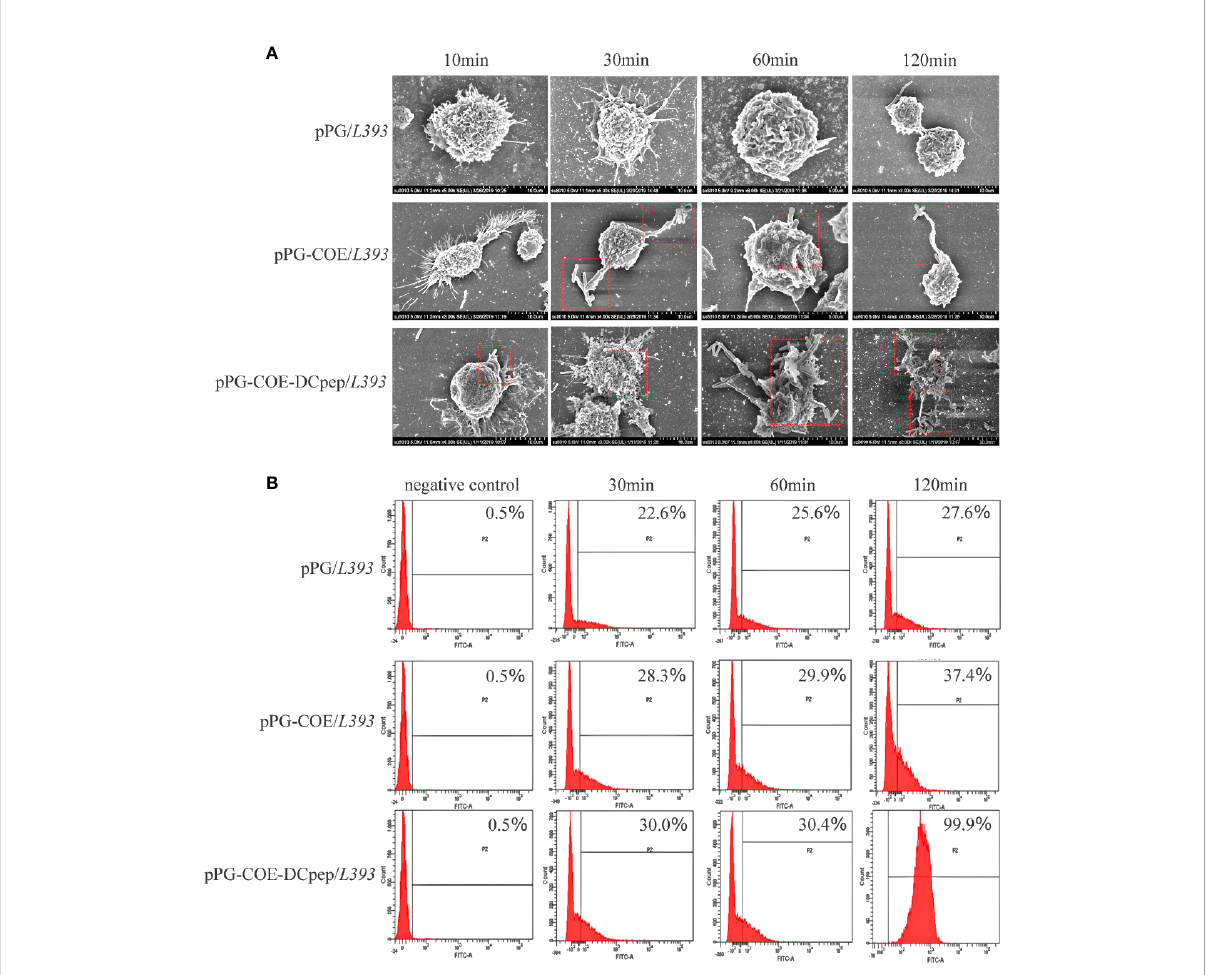
FIGURE 3 The ability of Mo-DCs to recognize and capture recombinant Lactobacillus was evaluated using scanning electron microscopy and fl ow cytometry. (A) Scanning electron microscopy images showing the morphology of Mo-DCs capturing recombinant Lactobacillu s at 10, 30, 60, 120 min. (B) Mo-DCs capturing recombinant Lactobacillus detected by fl ow cytometry. Mo-DC surface recombinant Lactobacillus abundance was expressed by % abundance for pPG/ L393 , pPG-COE/ L393 , and pPG-COE-DCpep/ L393 positive